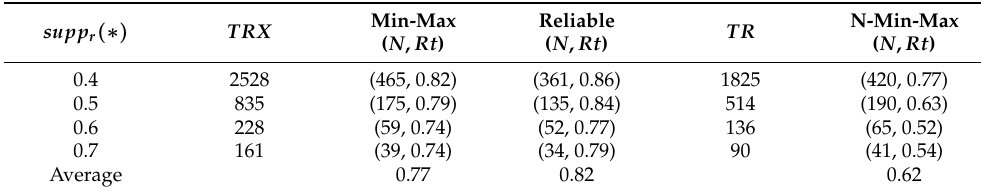
Table A8. The number of approximate rules and reduction in the mushroom database with confidence 0.5. c ≥